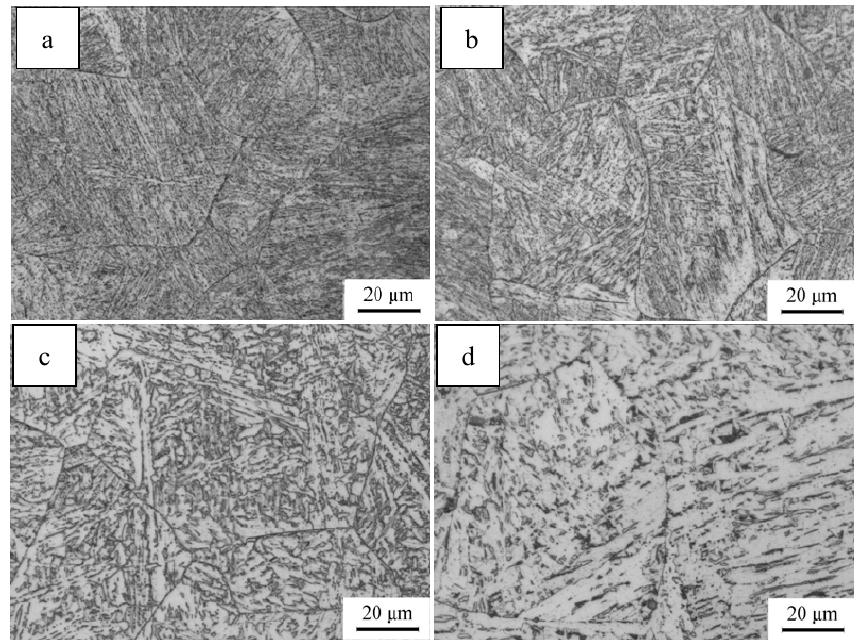
Figure 5. Simulated CGHAZ microstructure of experimental steel at different t 8/5 : ( a ) 10 s; ( b ) 20 s; ( c ) 40 s; and ( d ) 200 s.